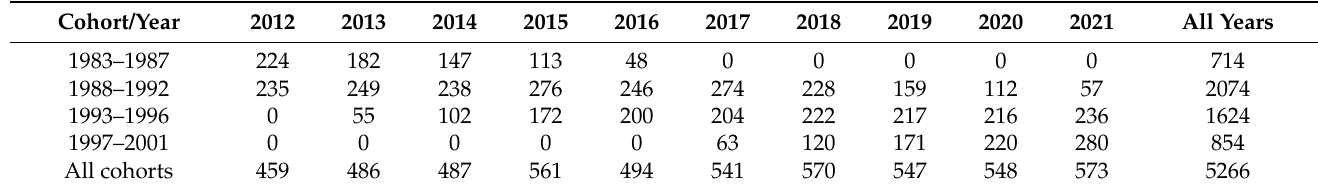
Table 1. Analytic sample size by birth cohort and survey year (unweighted